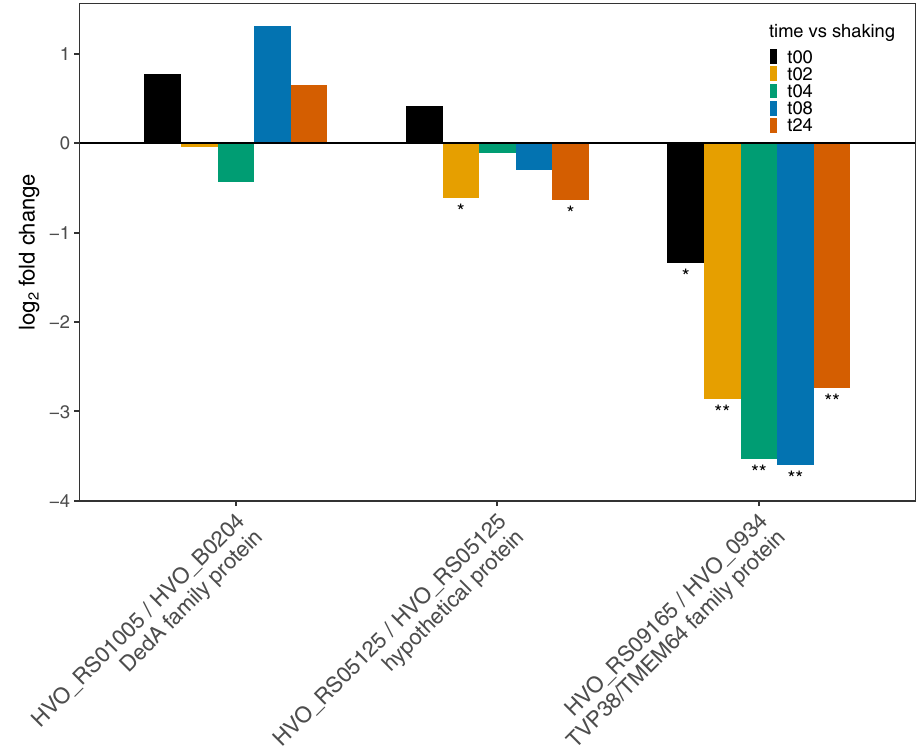
Figure 4. Bar plot depiction of differential expression compared to planktonic state for SNARE/ dedA motif genes; gene id on the x-axis and log 2 fold change on the y-axis, * p value < 0.05 and ** p value <